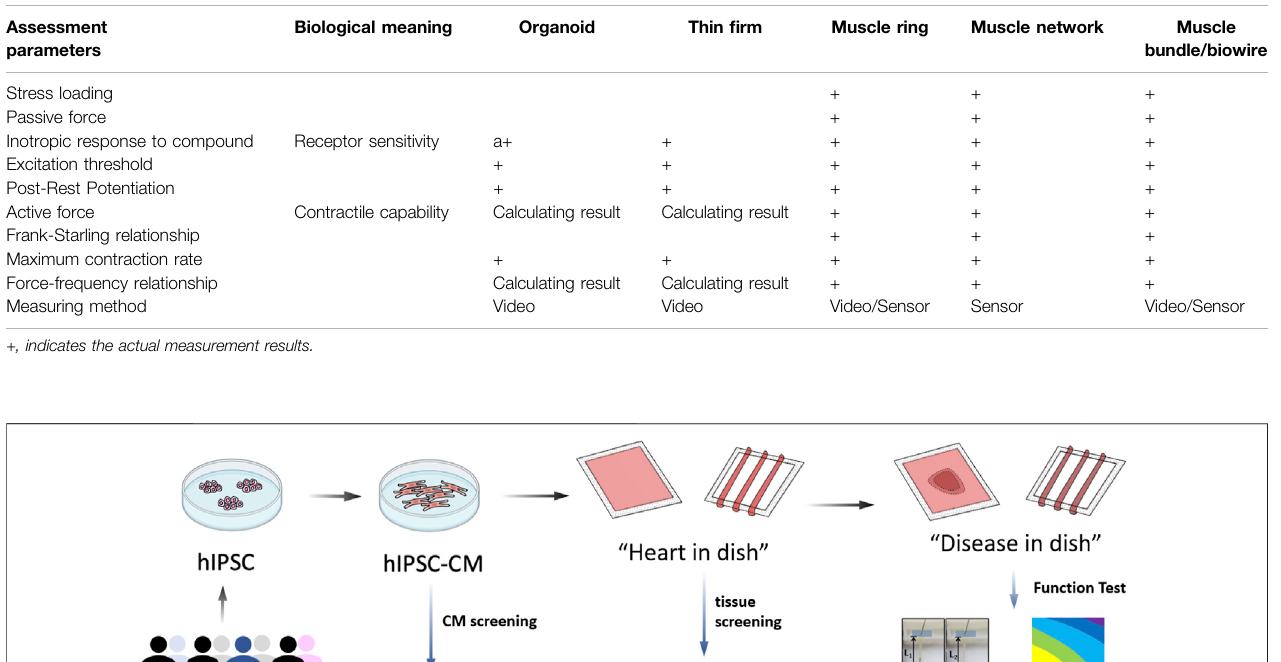
TABLE 1 | The application of various types of EHTs.